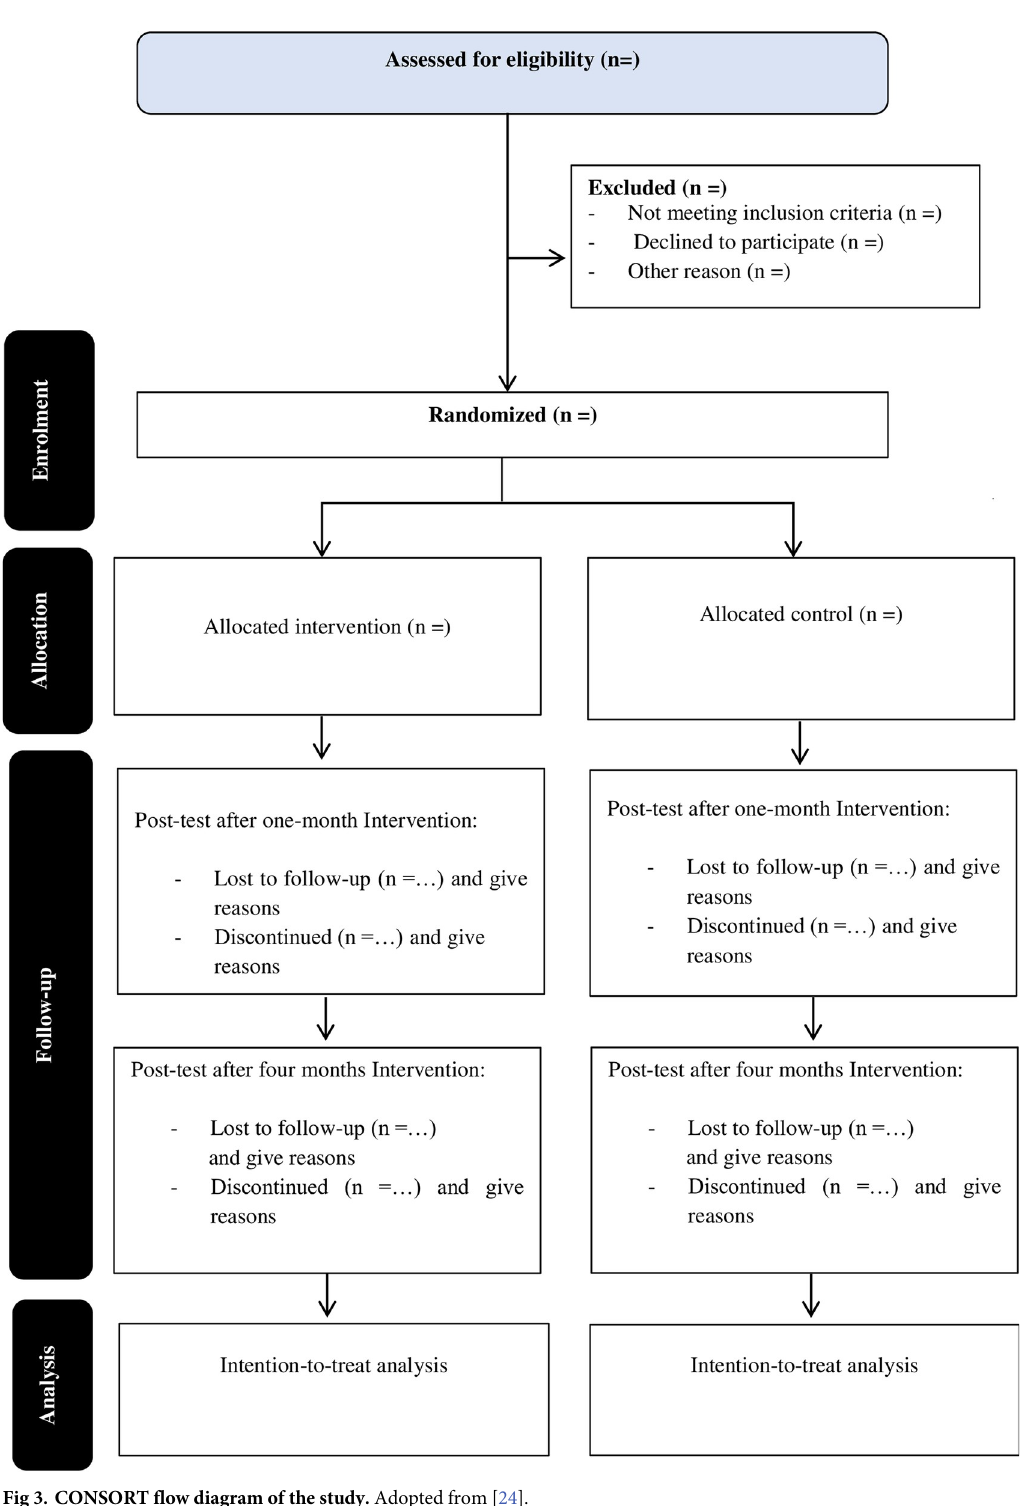
Fig 3. CONSORT flow diagram of the study. Adopted from [24].